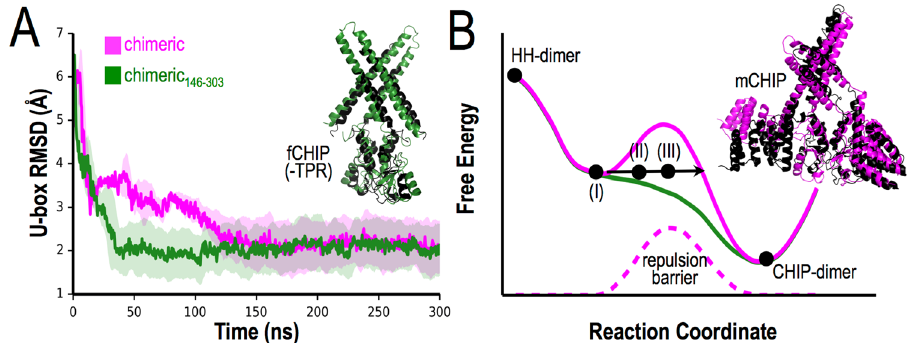
Figure 5. CHIP folds into a symmetric dimer in the absence of TPR. ( A ) Truncated HH-chimeric-dimer (CHIP 146–303 ) folds into a symmetric conformation similar to fCHIP in the absence of TPR domains (overlap backbone RMSD of 3.9 Å relative to PDB 2F42 shown in black). RMSD of interacting helices in the U-box dimer as a function of time for CHIP (magenta) and truncated CHIP (green) averaged over three independent runs. ( B ) Sketch of the free energy landscape of U-box dimerization in the presence (magenta) and absence (green) of TPR. CHIP dimerization triggers a repulsive barrier that prevents the U-boxes to properly align until after H7 breaks, and the TPR and U-box detach (dashed line). The snapping of H7 generates an out-of-equilibrium pathway that overcomes the thermodynamic barrier imposed by the TPR-U-box interaction. Approximate loci of specific structural transitions observed in the MDS dimerization trajectories in Fig. 4B,C and D are